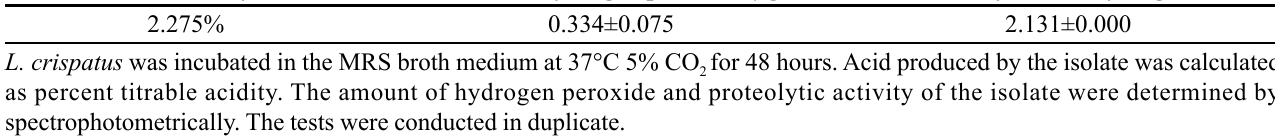
FIGURE 1 - Acid and bile salt resistances of L. crispatus. TABLE I - The amounts of lactic acid, hydrogen peroxide and proteolytic activity of the L. crispatus % of